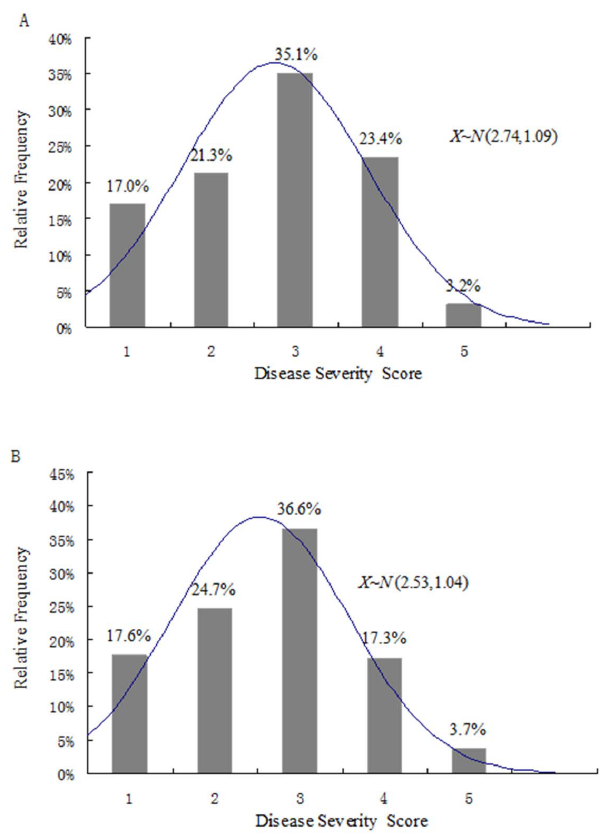
Fig. 1. Distribution of disease severity scores in the Pioneer (A) and Alforex populations (B). 1 5 resistant with no or minimal chlorosis of lower leaves; 2 5 moderately resistant with chlorosis of lower and middle leaves but no chlorosis of terminal leaves; 3 5 susceptible with well developed symptoms of chlorosis, and necrotic and twisted terminal leaflets on at least one, but not all main stems, 4 5 susceptible with severe symptoms of chlorosis, necrosis, and twisting of all leaflets on all main stems; and 5 5 dead